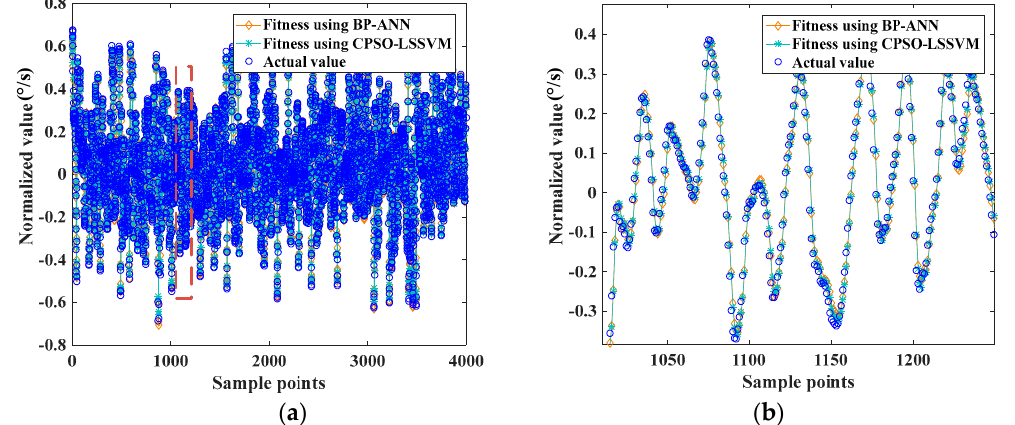
Figure 9. ( a ) The fitting effect of the training dataset using BP-ANN and CPSO-LSSVM; ( b ) partially enlarged detail of ( a ).